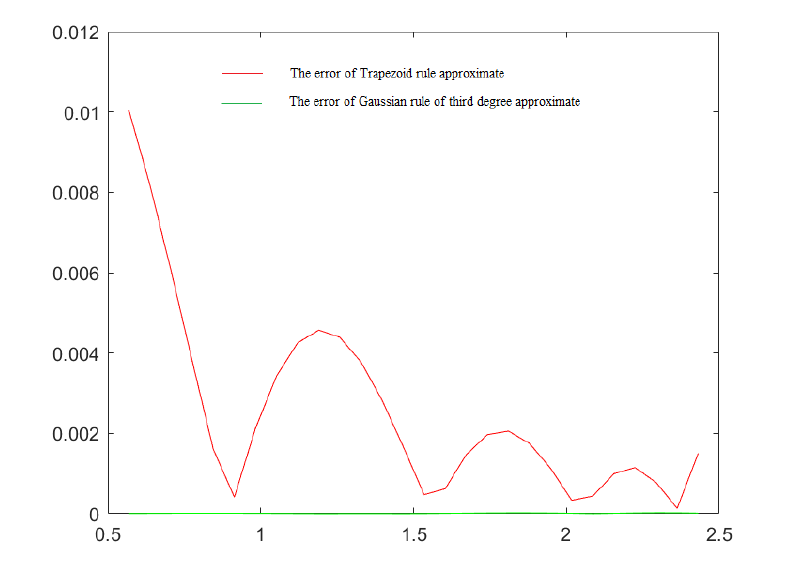
Figure 2. Error functions of two approximations of the original function in Example 2, given by inverse F 2 -transforms calculated using the trapezoid and the suggested quadratures. In the latter case, the errors are practically equal to